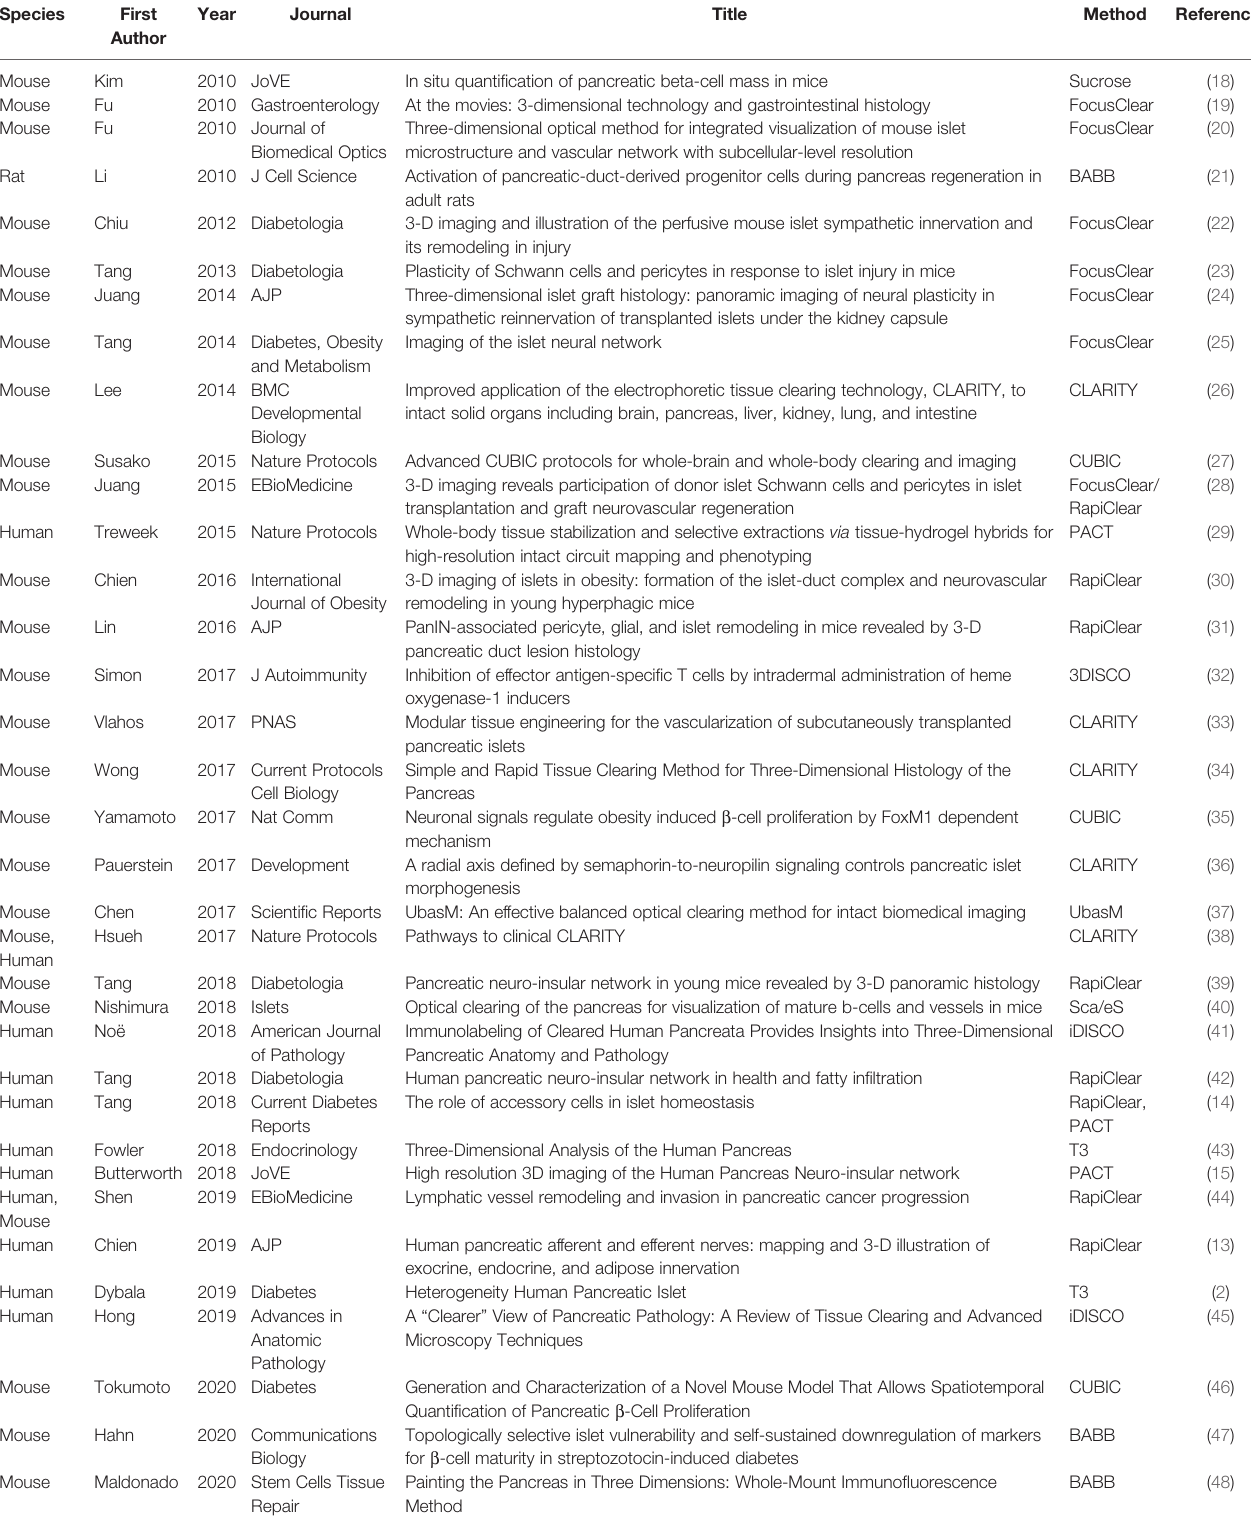
TABLE 1 | Optical clearing references in human and mouse